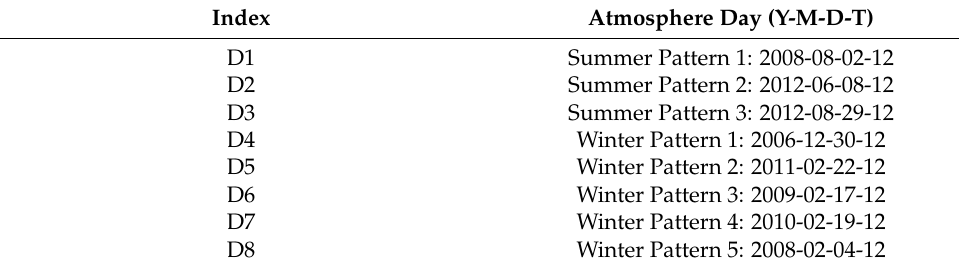
Table A1. Atmosphere data under consideration.